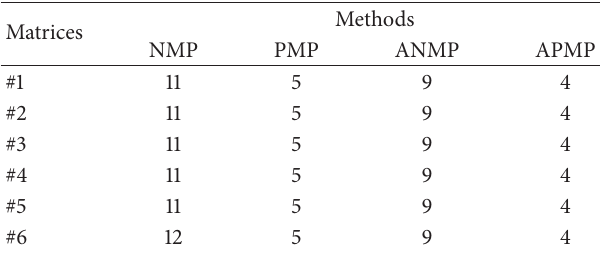
Table 3: Results of comparisons for Example 3 in terms of number of iterations.